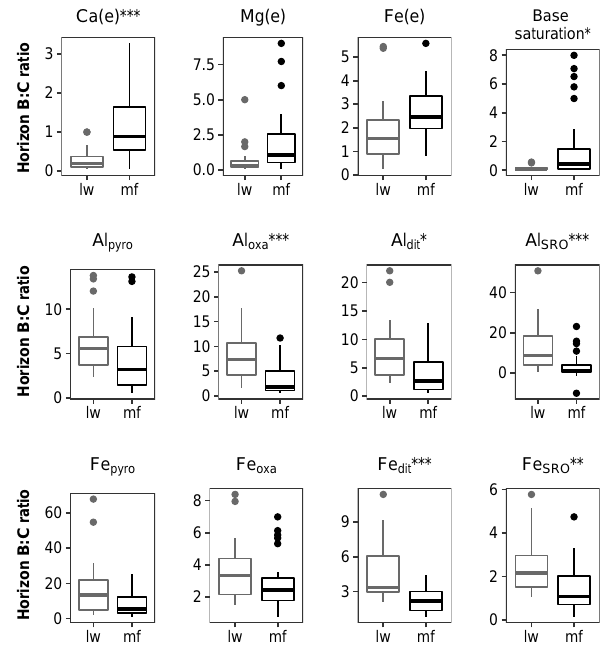
Figure 6. Comparison of horizons B:C ratios in lw and mf plots. Ratios were calculated by dividing for each soil type concentra- tion measured in the B horizon by that measured in the C hori- zon. “(e)” indicates exchangeable or extractable elements. “Pyro”, “oxa” and “dit” subscripts mention the type of extractions used for isolating Fe and Al species (respectively pyrophosphate, ox- alate and dithionite–citrate). “SRO” stand for short-range order species (Al SRO = Al oxa -Al pyro , Fe SRO = Fe oxa -Fe pyro ) . Asterisks indicate statistical significance using mixed models (see Materials and methods), with ∗ p value<0.05, ∗∗ p value<0.01 and ∗∗∗ p value<0.001.